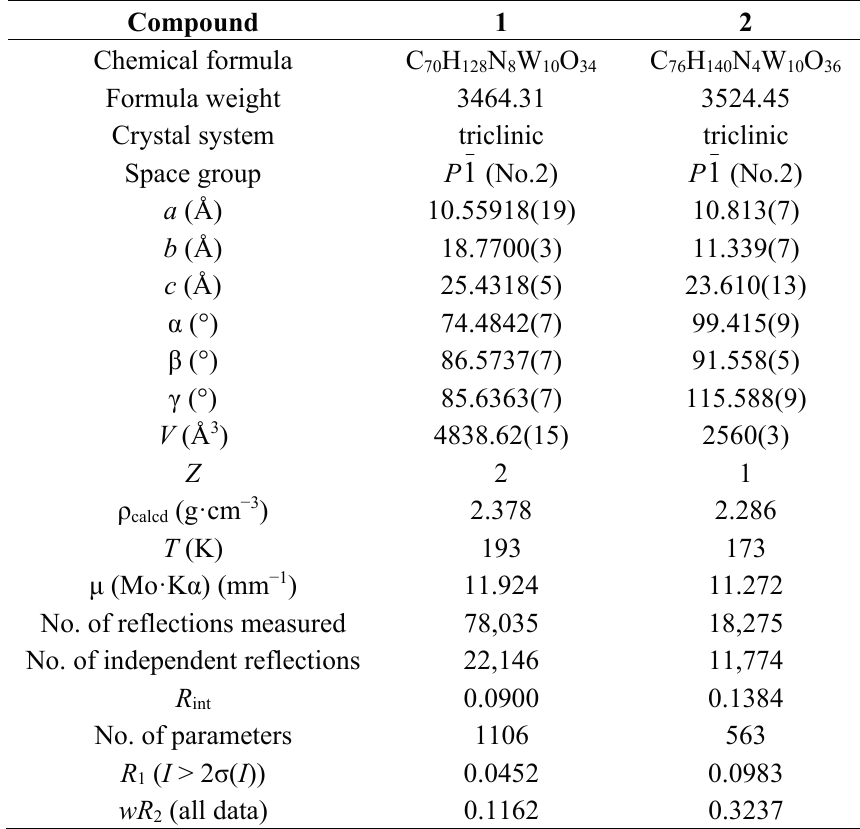
Figure 1. IR spectra of W 10 compounds. (a) Na-W 10 as a starting material; (b) As-prepared sample of 1 ; (c) 1 after recrystallization; (d) As-prepared sample of 2 . Table 1. Crystallographic